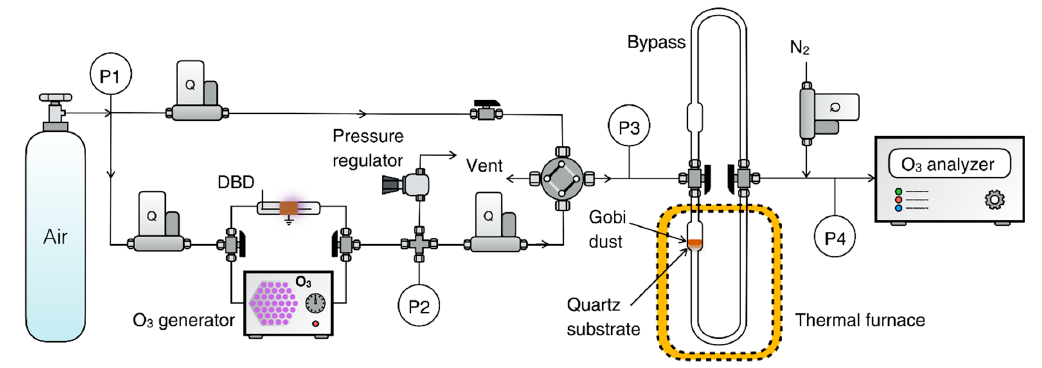
Figure 4 . General scheme of the experimental setup. Figure 4. General scheme of the experimental